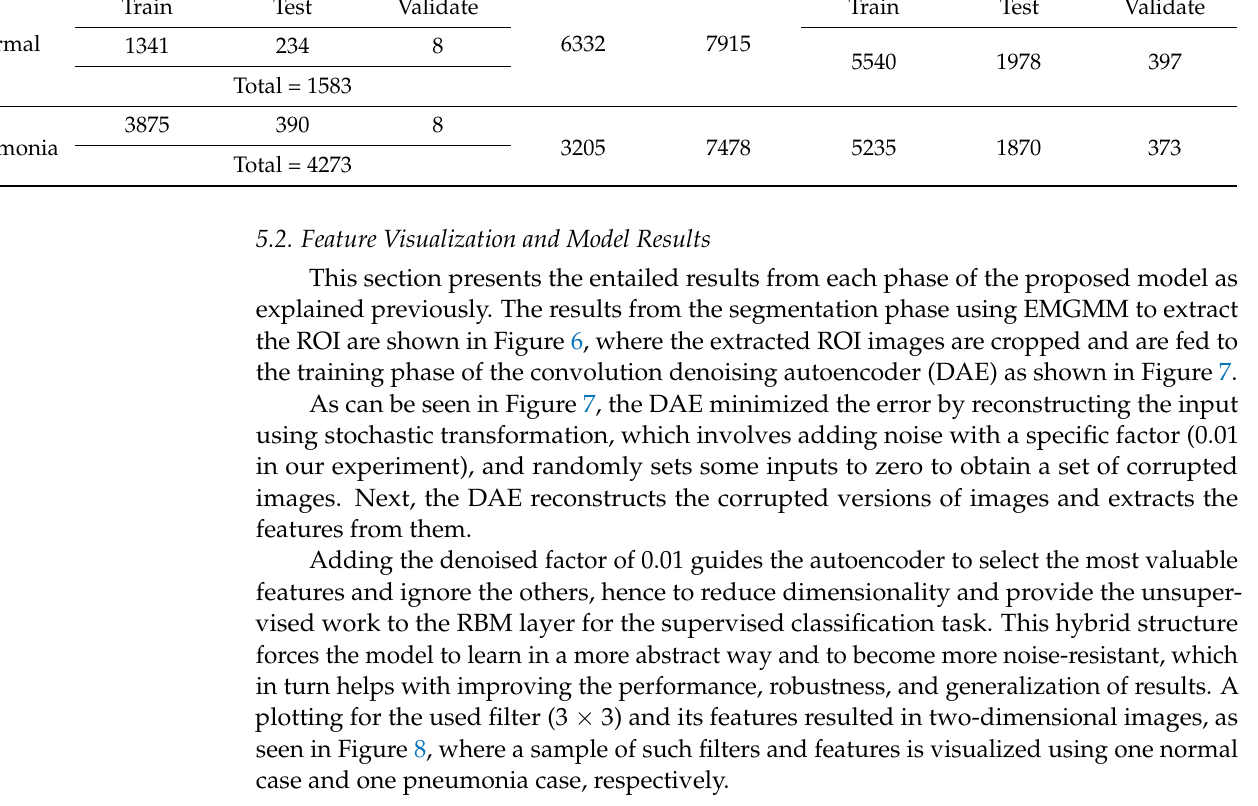
Table 1. Data set distribution before and after augmentation and class balancing.